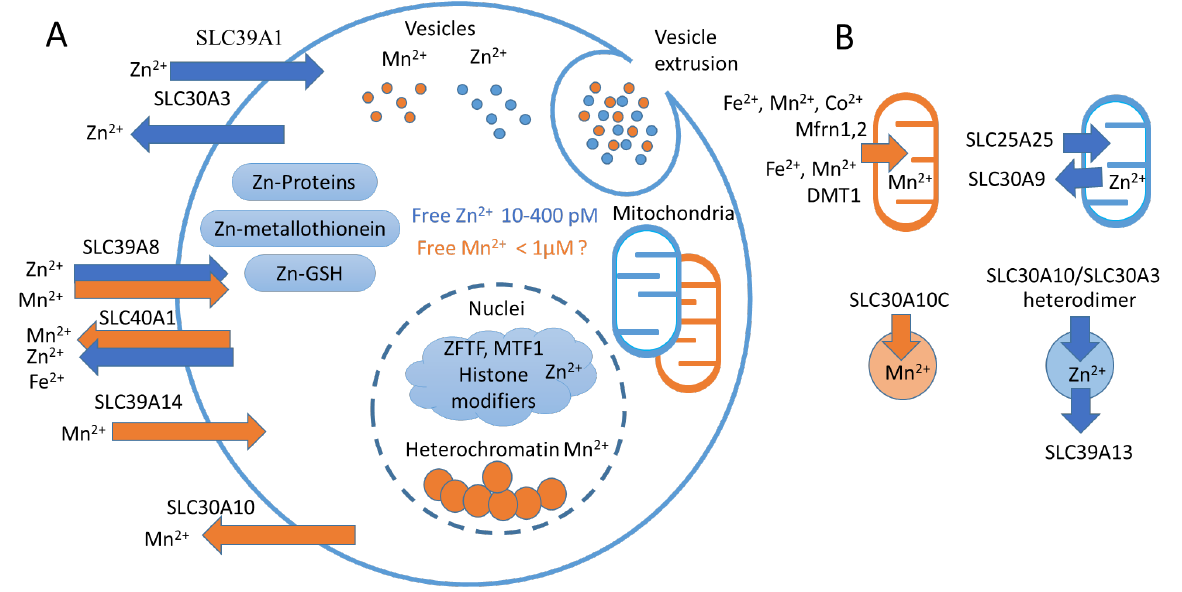
Figure 3. Mn 2+ and Zn 2+ homeostasis. ( A ) Representative scheme of Mn 2+ and Zn 2+ transport and cellular compartments. Blue arrows represent Zn 2+ -transporting carriers (SLC39A1, SLC30A3), orange arrows represent Mn 2+ -transporting carriers (SLC39A14, SLC30A10). Double arrows represent proteins that transfer both Mn 2+ and Zn 2+ (SLC39A8, SLC40A1). In the cell, Zn 2+ is distributed between metallothioneins, other proteins and GSH [84,85]. In the nuclei, Zn 2+ binds MTF1 [25] and serves as a coordination metal for the majority of histone-modifying enzymes [112,113] and zinc finger transcription factors (ZFTFs) [114]. In turn, Mn 2+ accumulates in heterochromatin [66]. Both Mn 2+ and Zn 2+ can accumulate in mitochondria [3,8], as well as in the Golgi apparatus and endoplasmic reticulum [10,11,115,116] (not shown). Both Mn 2+ and Zn 2+ can be sequestered in specific vesicles that can be released from the cell [9,26,27]. ( B ) Ion carriers transfer Mn 2+ in mitochondria using Mfrn1 [117] and DMT1 [118], and in cellular vesicles by SLC30A10 [108]. In turn, Zn 2+ is accumulated in mitochondria by SLC25A25 and exerted by SLC30A9 [8,23]. In vesicles, Zn 2+ is accumulated by SLC30A3-SLC30A10 heterodimer [107] and exerted by SLC39A13 [119].